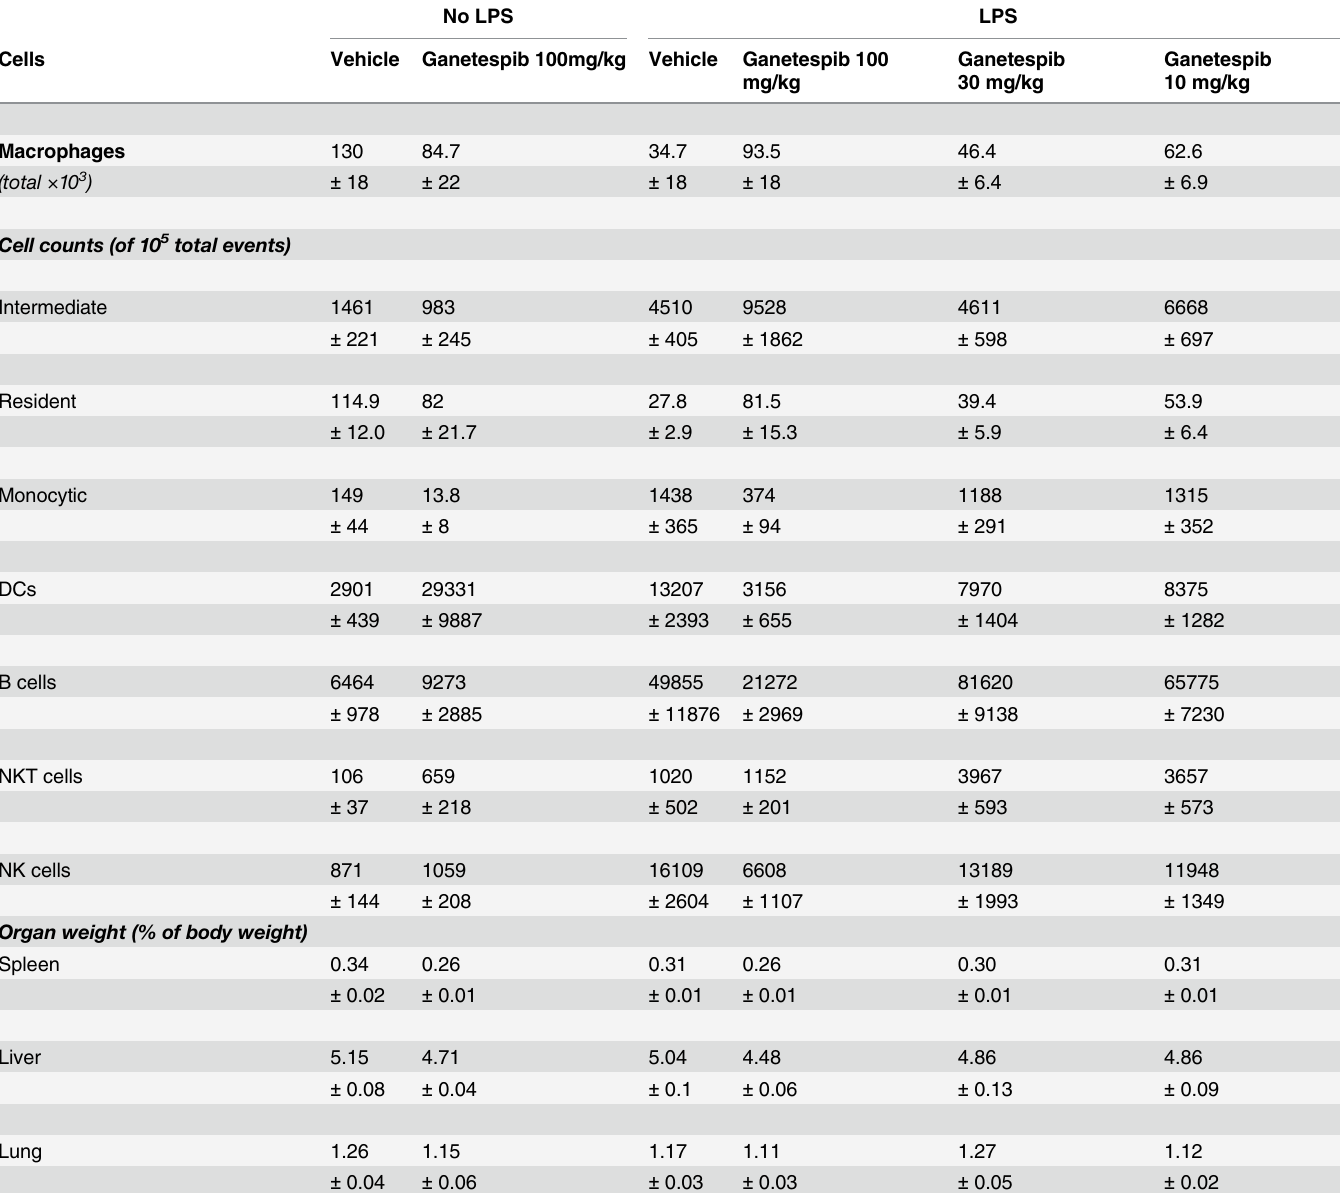
Table 1. BALF cell pro fi les and organ weights in Ganetespib treated